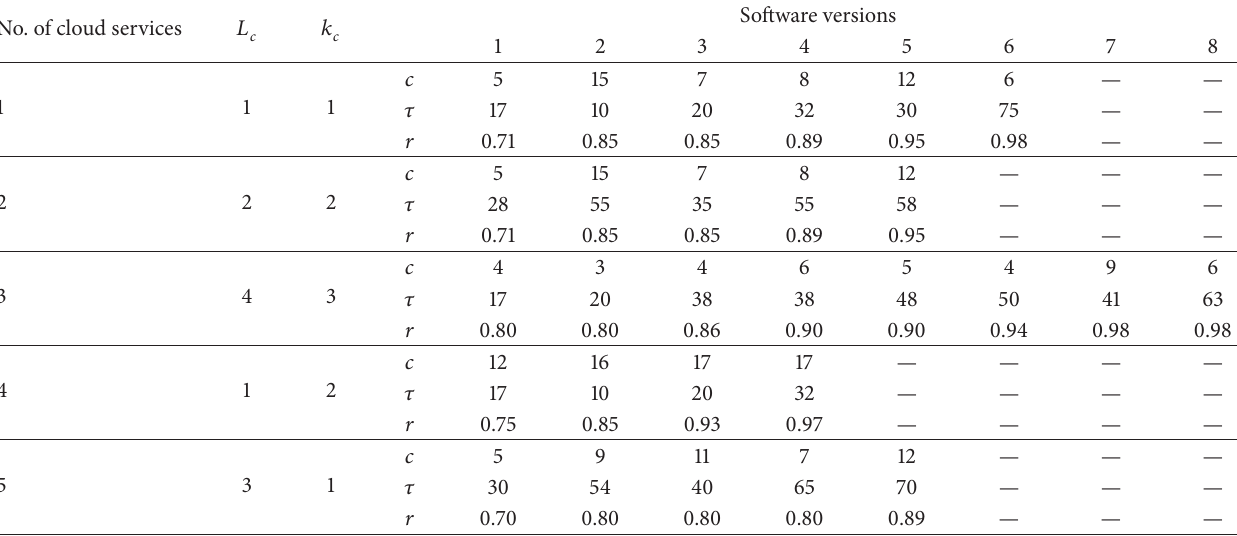
Table 1: Parameters of fault-tolerant cloud services and software